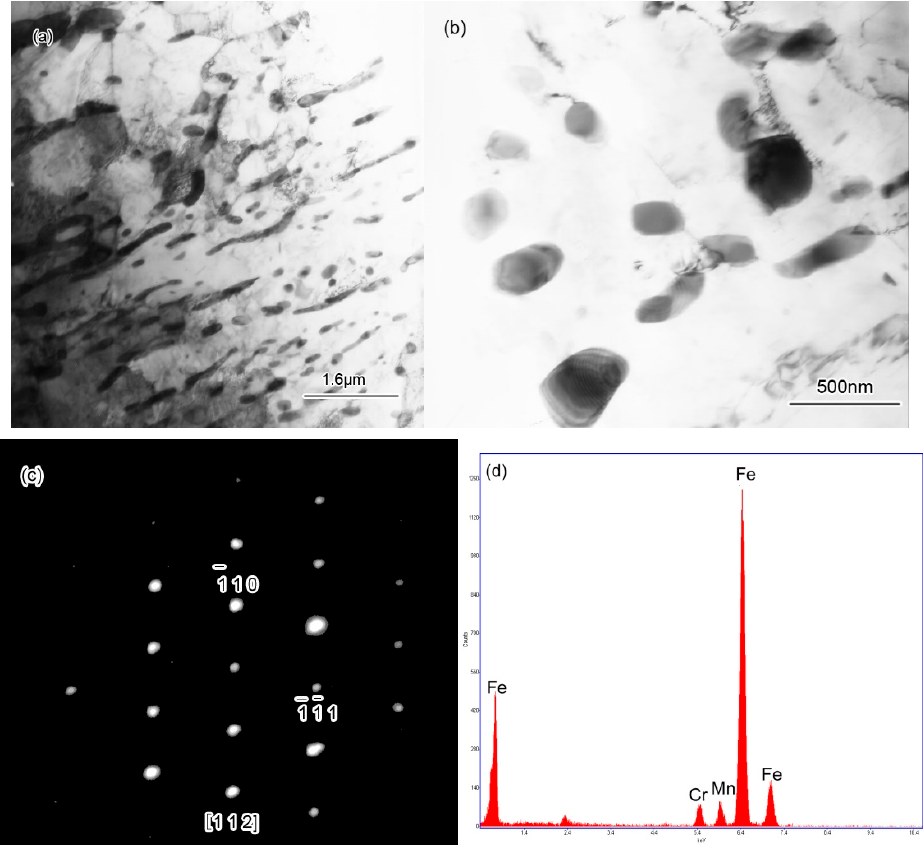
Figure 5. Micrographs of particles within bainite: ( a ) 680-2, ( b ) 680-100, ( c ) SAED pattern, and ( d ) EDX.